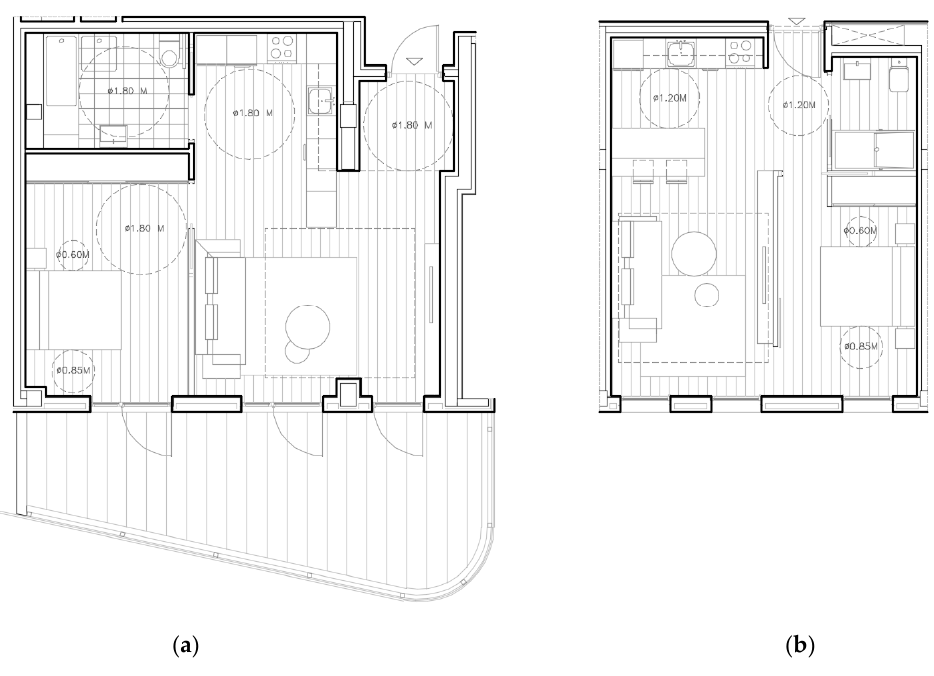
Figure 4. Type II ( a ) accessible AD and Type I ( b